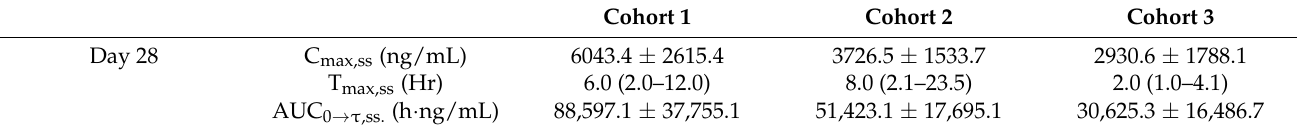
Table 3. Sorafenib and GW5074 pharmacokinetic